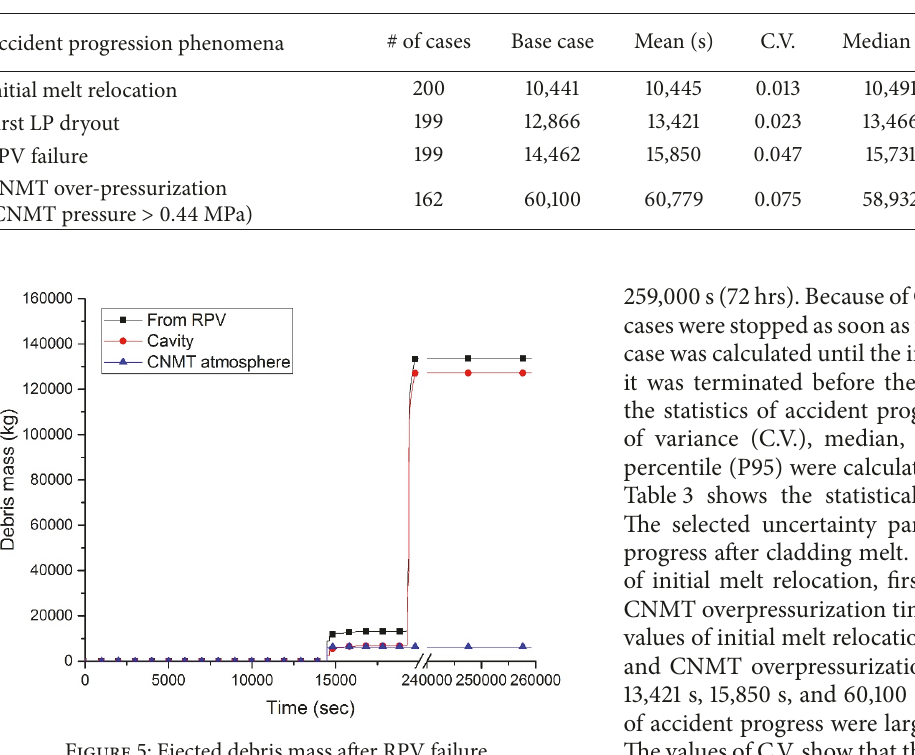
Figure 5: Ejected debris mass after RPV failure.